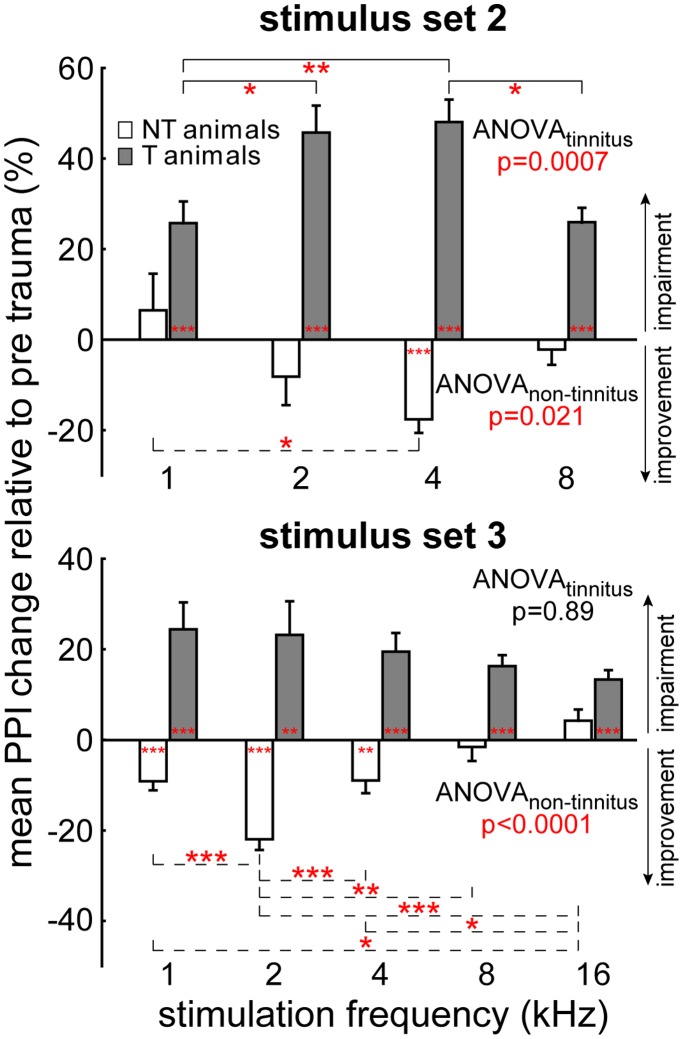
Behavioral tinnitus tests (gap-noise paradigms) in 35 animals.Mean normalized PPI response changes relative to pre trauma (in percent ± SEM) of group T (black) and NT (white); upward deviations indicate PPI impairment indicative for an existing tinnitus percept, downward gives PPI improvement. Upper panel: stimulus set 2, the responses are sorted for startle stimulus frequency. Lower panel: stimulus set 3, the responses are sorted for the bandpass noise center frequency. Significance levels of single sample t-tests vs. 0 indicating an impairment or improvement for each frequency and the Tukey-tests of the 1-factorial ANOVA indicating frequency specific impairment or improvement: * p<0.05, ** p<0.01, *** p<0.001.